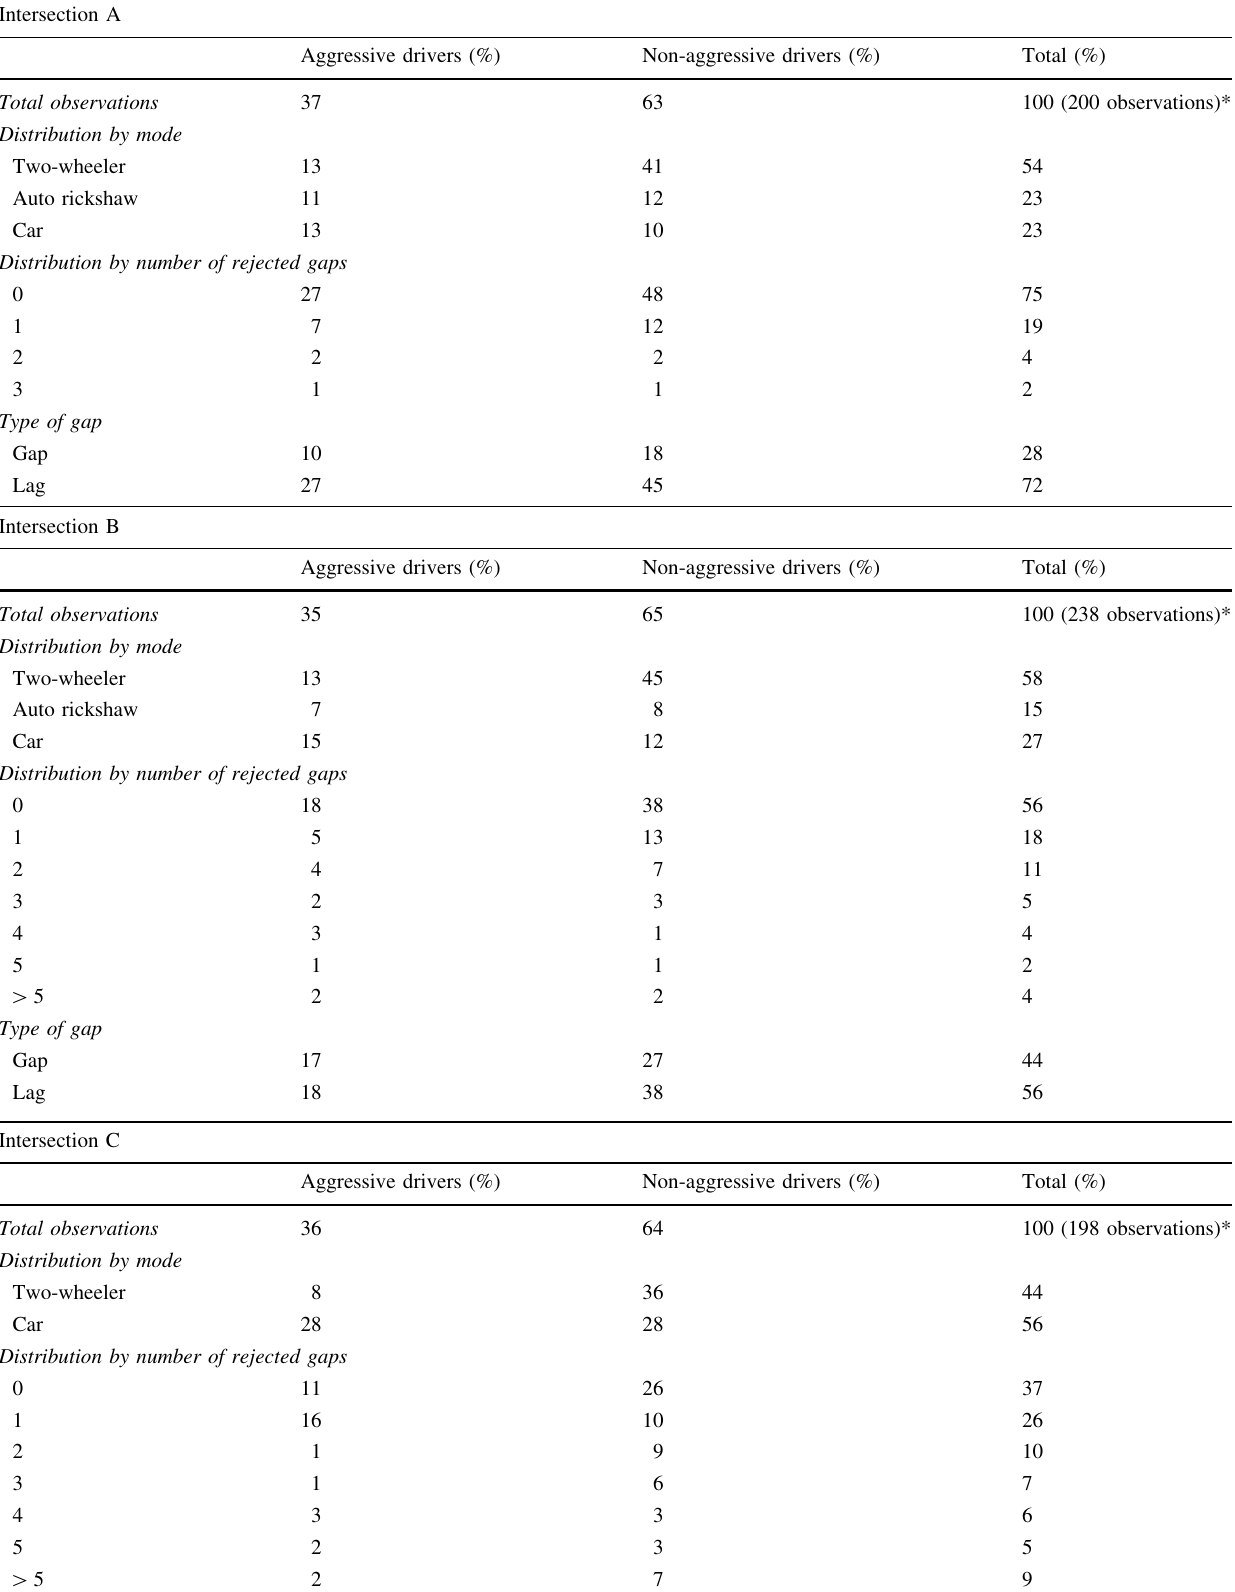
Table 1 Statistical summary of the obtained